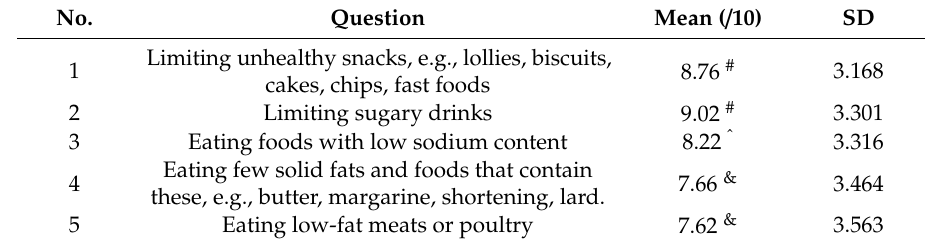
Table 1. Family day care (FDC) educators’ confidence of making nutritional recommendations to parents (n = 188).